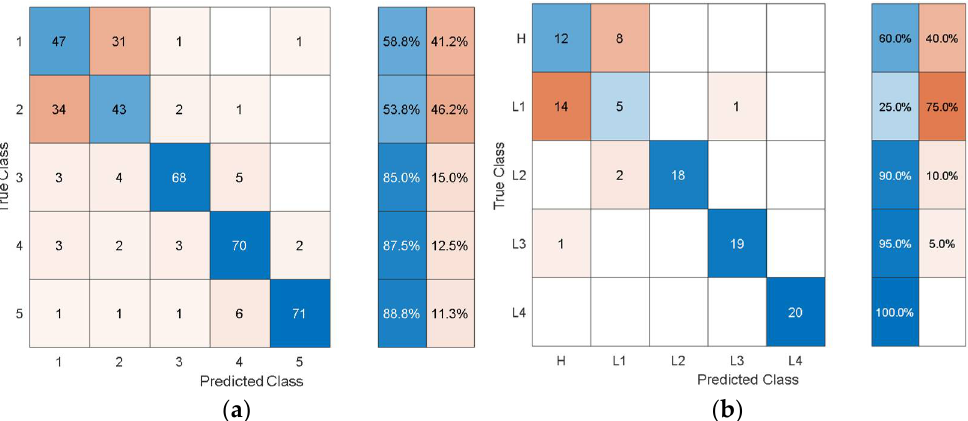
Figure 11. Classification performance of SVM using the autonomous features from the 66th layer of SqueezeNet in terms of its confusion matrices: ( a ) training; ( b ) test.